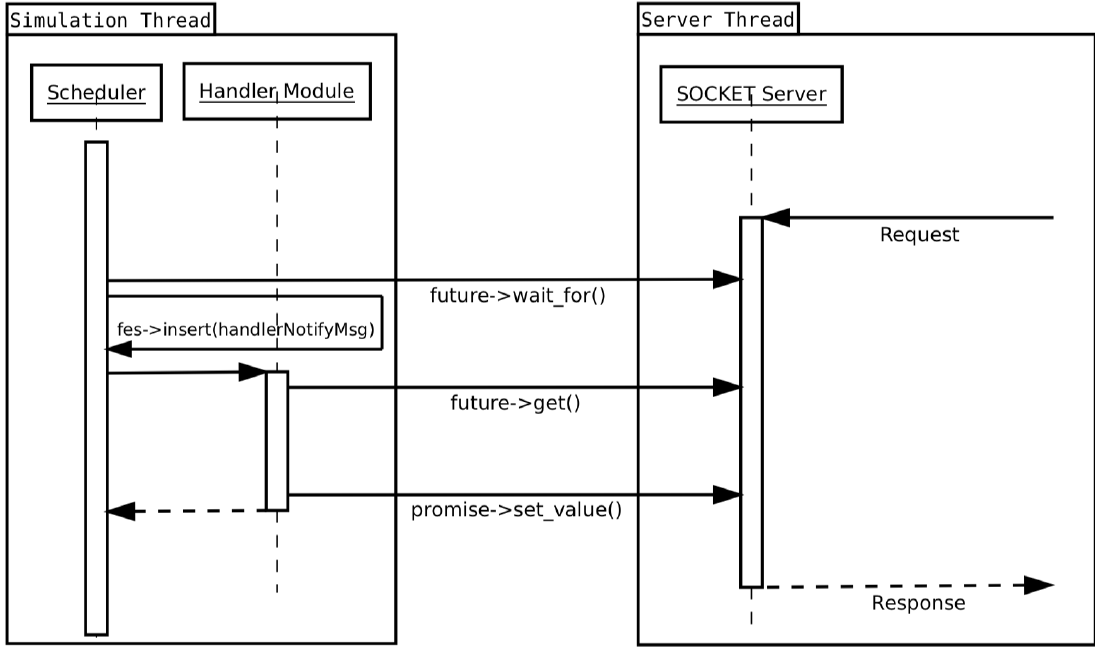
Figure 3. Simulation- and server-thread